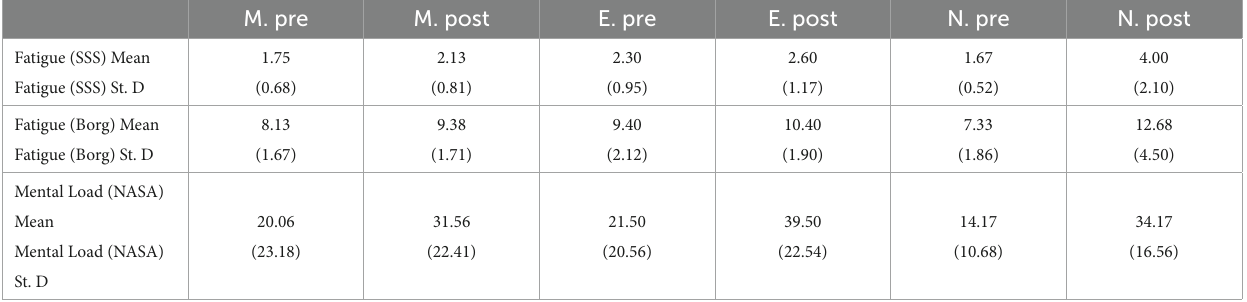
TABLE 3 Descriptive statistics fatigue and mental load pre and post